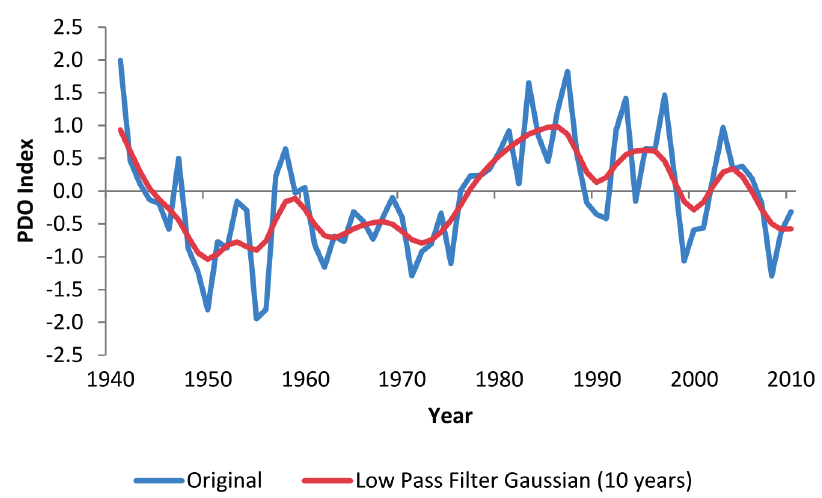
Figure 3. Pacific Multidecadal Oscillation